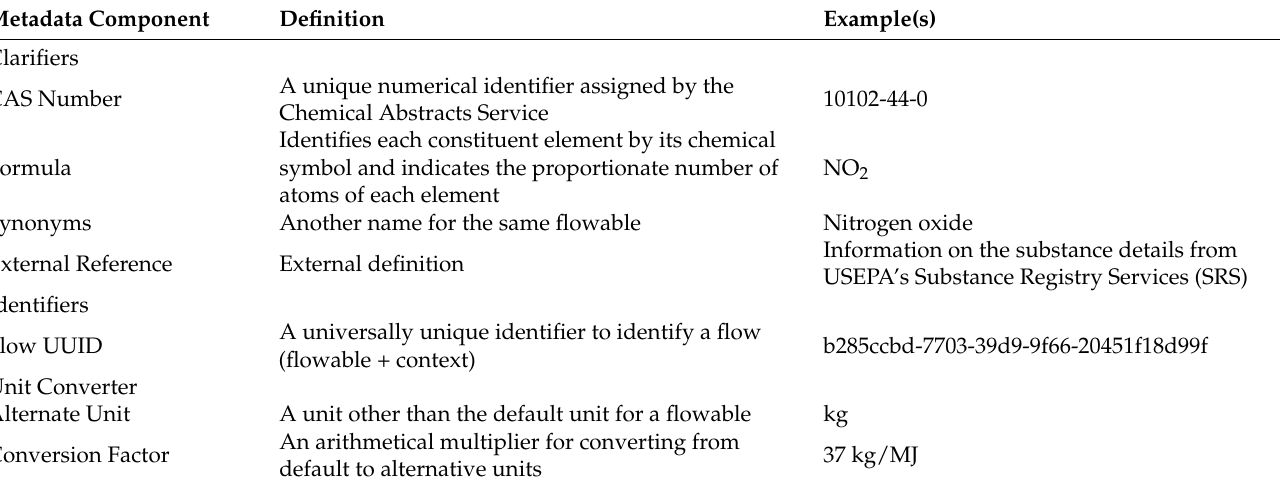
Table 1. Components of flow metadata.